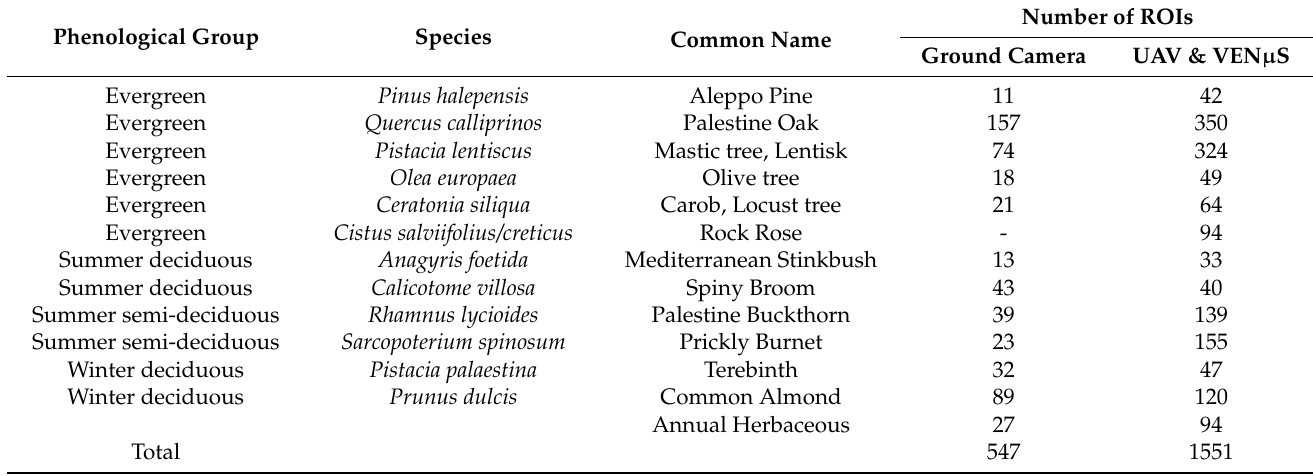
Table 2. List of the species analyzed with the number of individuals for each species per